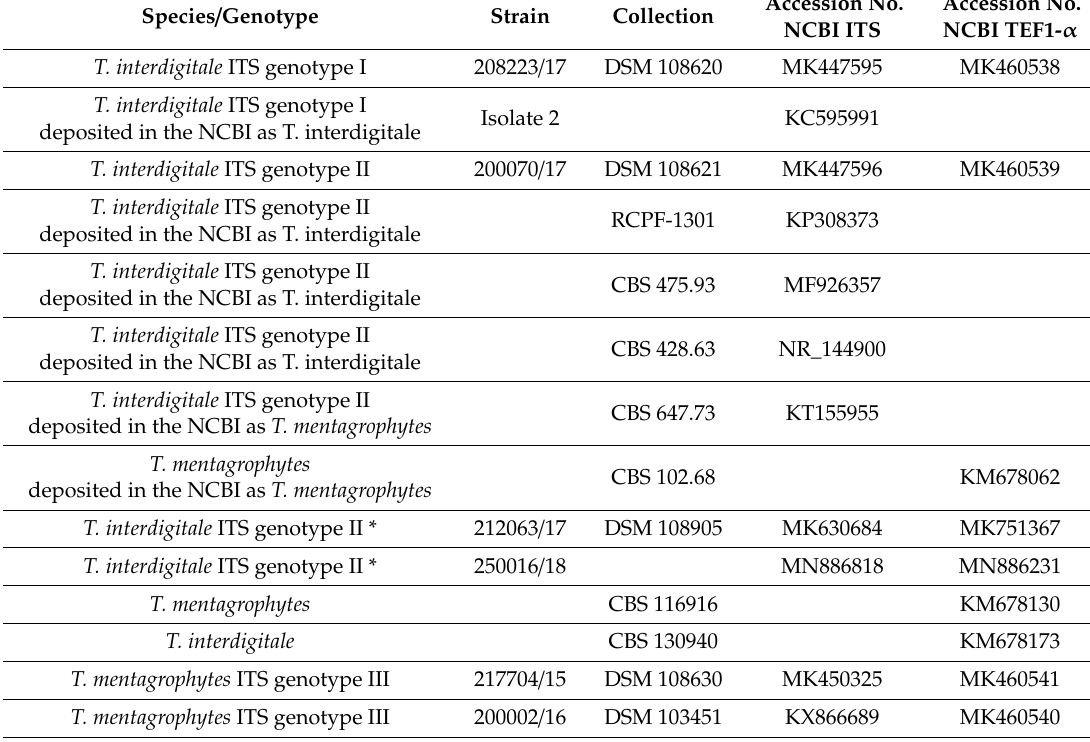
Table 2. Reference strains and clinical isolates used to generate the phylogenetic tree based on sequencing of the ITS region of rDNA and the TEF1- α gene. GenBank accession numbers of the nucleotide sequences used in this study are available at the NCBI. Abbreviations: NCBI, National Center for Biotechnology Information, Bethesda, Maryland; ITS, internal transcribed spacer; rDNA, ribosomal DNA; TEF1- α , translation elongation factor 1- α ; CBS, Centraal Bureau voor Schimmelcultures (today, Westerdijk Fungal Biodiversity Institute, Utrecht, The Netherlands); DSM, T. mentagrophytes Deutsche Sammlung von Mikroorganismen und Zellkulturen (German Collection of Microorganisms and Cell Cultures), Braunschweig, Germany; ATCC, American Type Culture Collection (Manassas, VA,